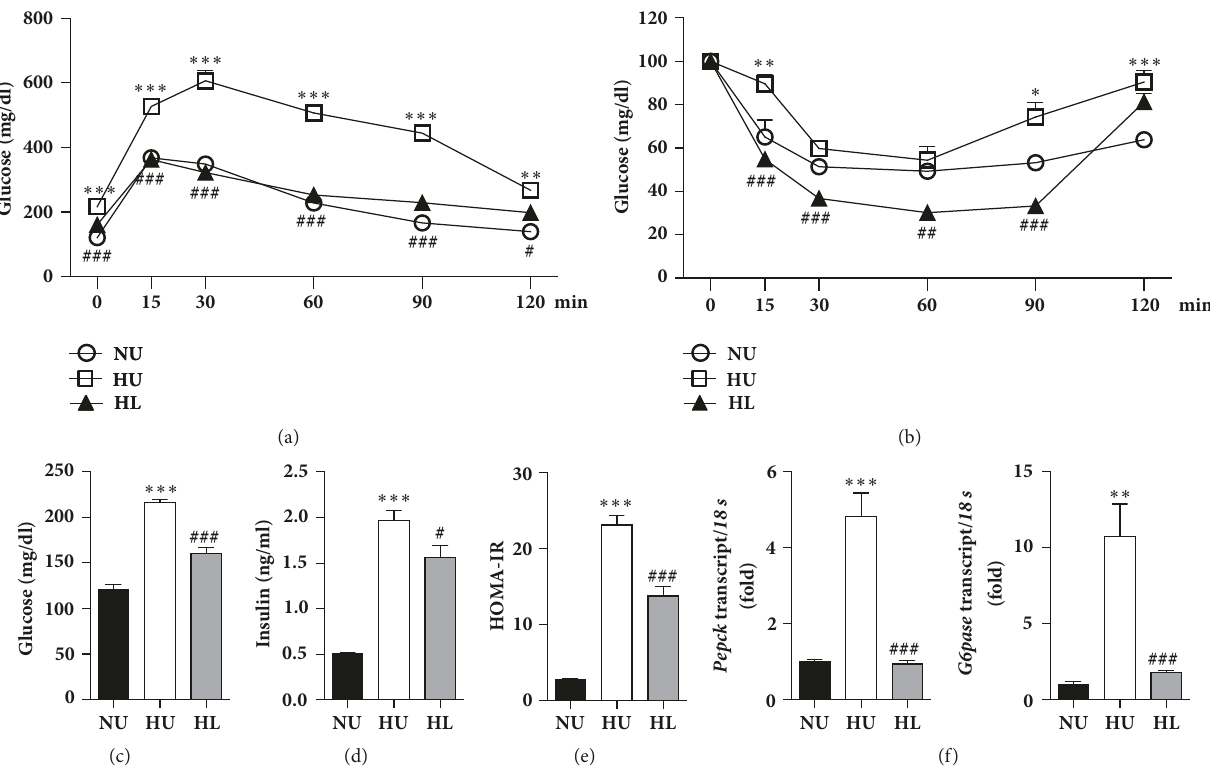
Figure 1: Lobeglitazone treatment improves systemic insulin resistance in high fat diet- (HFD-) fed mice. (a) The glucose tolerance test. Glucose (1 g/kg body weight) was intraperitoneally (i.p.) injected in overnight-fasted mice. (b) The insulin tolerance test. Blood glucose levels were measured at the indicated time points before and after i.p. injection of human regular insulin (0.75 U/kg) in mice fasted for 4 hours. (c) The fasting blood glucose level. (d) The fasting blood insulin level. (e) A homeostasis model for assessment of the insulin resistance index (HOMA-IR). (f) The gene expression levels of PEPCK and G6Pase related to gluconeogenesis were determined by qPCR in liver tissues. NU: normal chow diet- (NCD-) fed mice without treatment (NU, white circles and black bar), HU: HFD-fed mice without treatment (white squares and white bar), and HL: HFD-fed mice with lobeglitazone treatment (black triangles and gray bar). Data are expressed as means ± SEM. ∗ p < 0.05, ∗∗ p < 0.001, and ∗∗∗ p < 0.0001, NU versus HU group. # p < 0.05, ## p < 0.001, and ### p < 0.0001, HU versus. HL